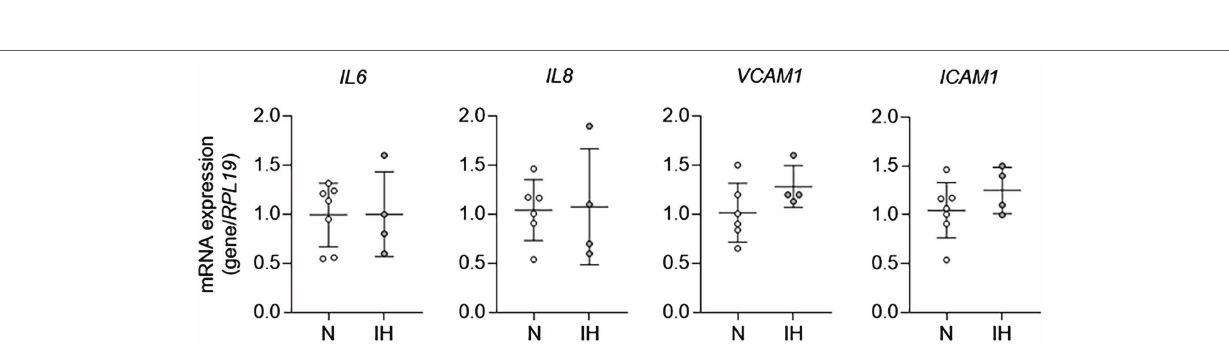
FIGURE 1 | Intermittent hypoxia induces activation of aortic endothelial cells (ECs) in mice. We exposed C57BL/6 mice to either normoxia (N) or IH for 10 days and removed and flushed aorta with TRI Reagent to isolate RNA from aortic ECs and then assessed EC activation by measuring mRNA expression of markers of EC activation genes, including il6 , kc , vcam1 , and icam1. N = 5–6. Significance was determined by Student’s t -test. * p < 0.05, ** p < 0.005, and **** p <